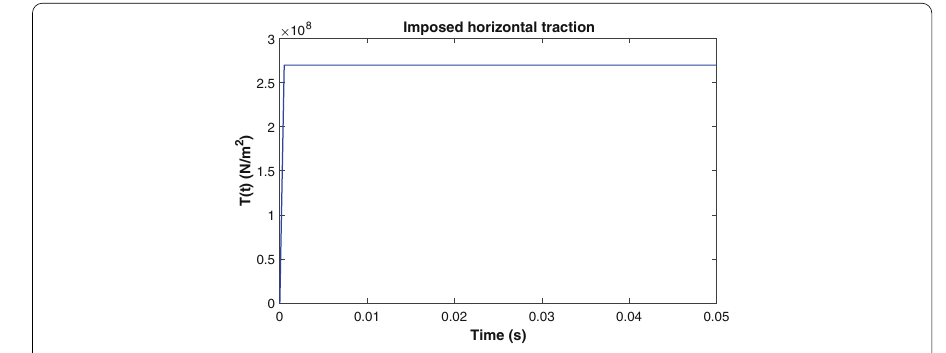
Fig. 13 Horizontal loading for the elasto-plastic dynamical problem